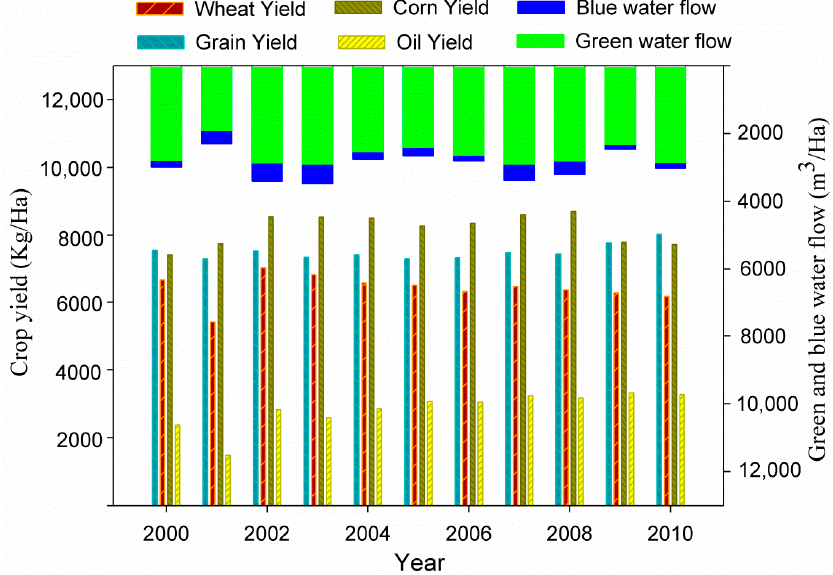
Figure 5. Ecosystem services of green and blue water flow for croplands. Water 2019 , 11 FOR PEER REVIEW